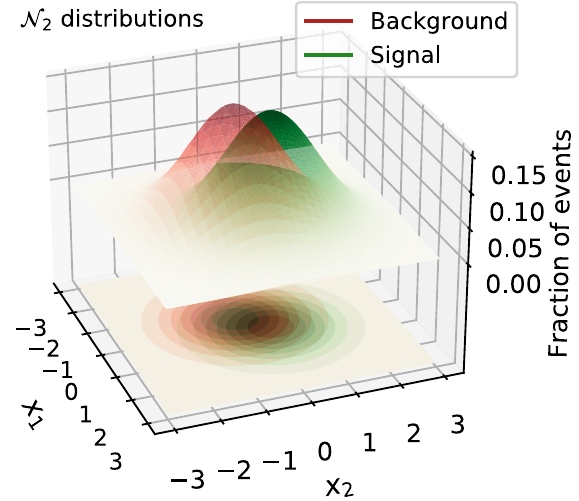
Fig. 1 Multivariate Gaussian random variables, dim = 2 example. ( + 0 . 3 1 , I )( x ) for signal, N N 2 2 2 × 2 ground